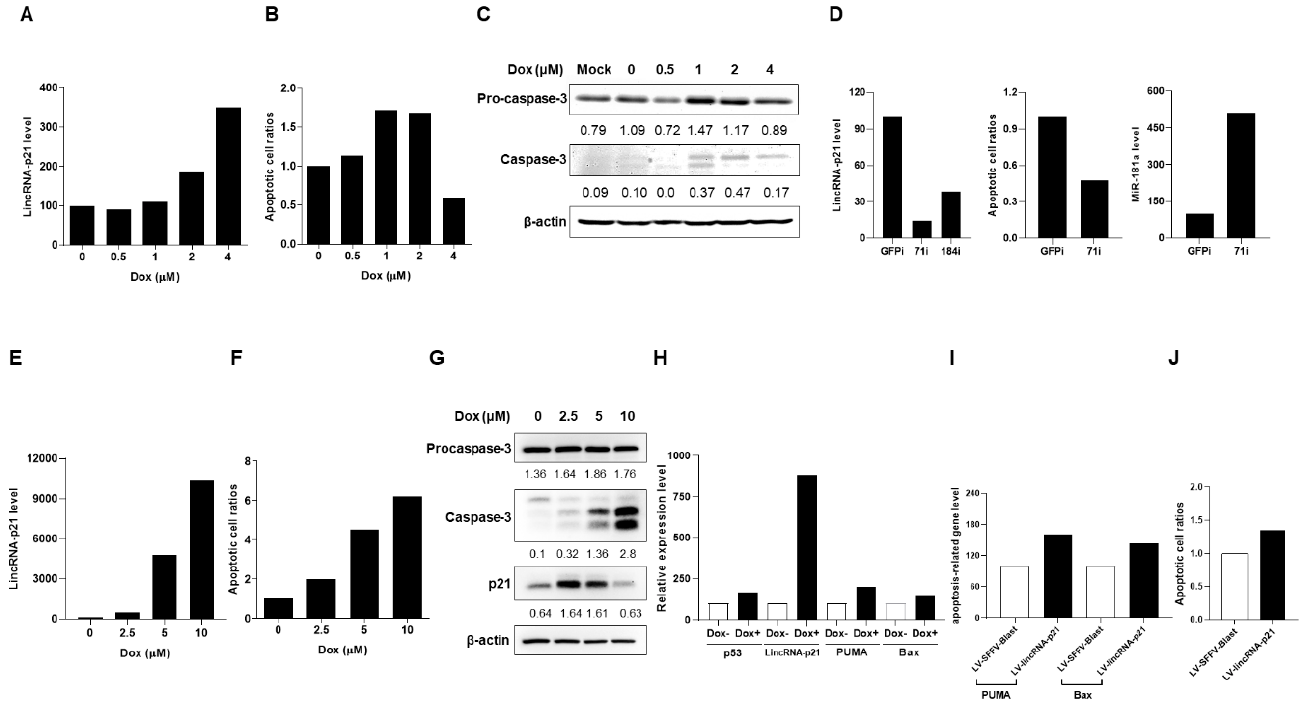
Figure 5. Up-regulated expression of lincRNA-p21 in apoptotic kidney cell lines. ( A – C ) Dose-dependent up-regulated lincRNA-p21 levels and apoptotic cell ratios and increases in caspase 3 levels in HEK 293T cells culture under the Dox treatment. ( D ) Two CRISPRi-lincRNA-p21 transfectants and decreased Dox-induced apoptotic cell ratios with increased miR-181a levels shown in 71i with higher silenced efficacy. ( E – G ) Dose-dependent up-regulated lincRNA-p21 levels and apoptotic cell ratios and increases in caspase 3/p21 levels in HK-2 cells under the Dox treatment. ( H ) Up-regulated expression of p53 down-stream molecules PUMA and Bax in HK-2 cells culture under the Dox 5 µ M treatment. ( I ) Enhanced expression of p53 down-stream molecules PUMA and Bax and ( J ) enhanced Dox-induced apoptotic cell ratios in lincRNA- p21-overexpressed HK-2 cells. All of the results in Figure 5 were representative of at least two independent experiments with similar findings.